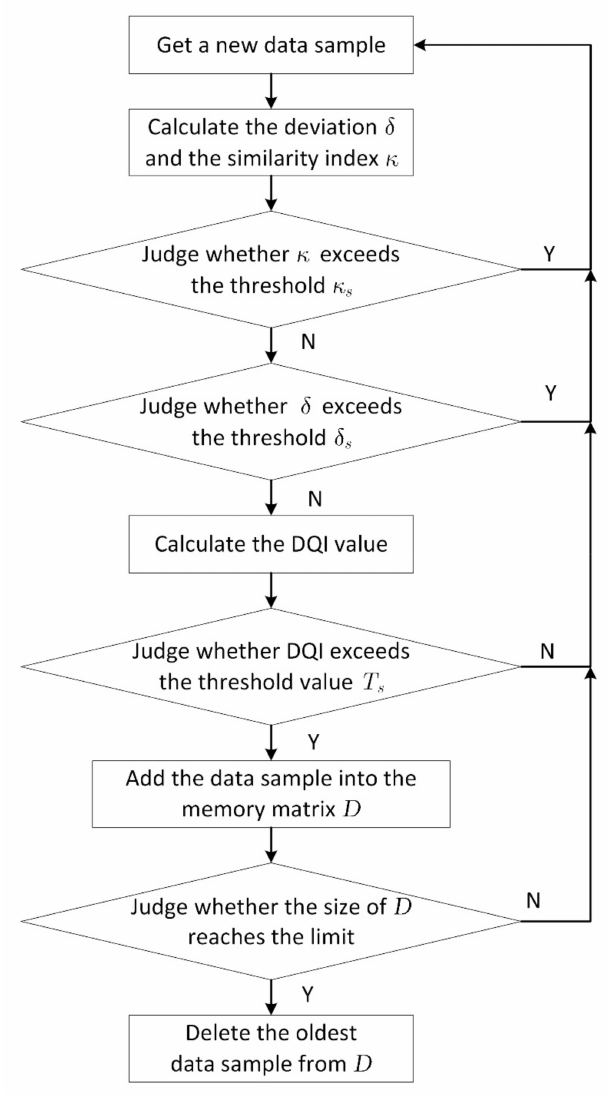
Figure 2. Memory matrix update